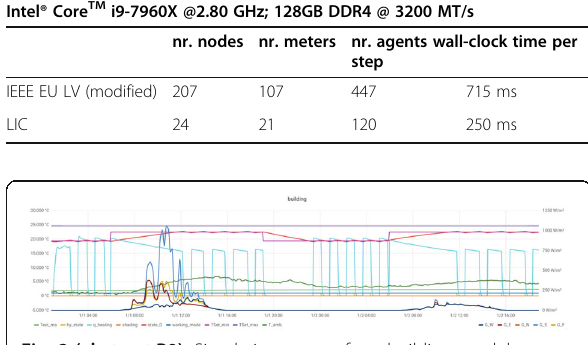
Fig. 2 (abstract P9). Simulation output for a building model